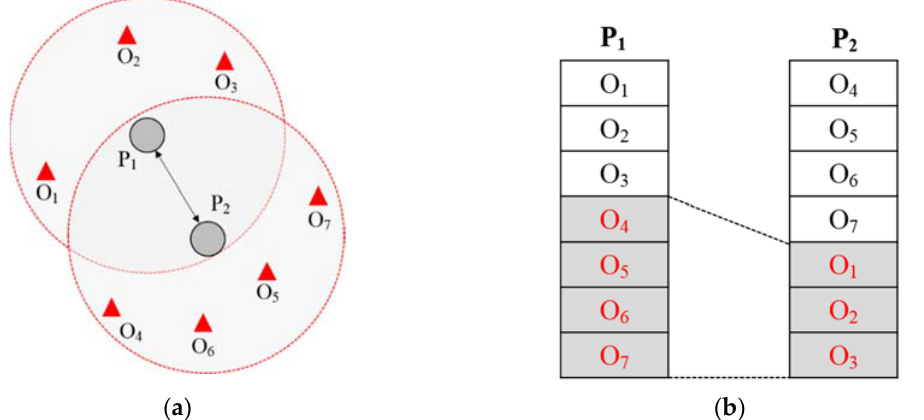
Figure 4. Data dissemination between P 1 and P 2 : ( a ) Communication between P 1 and P 2 ; ( b ) Data dissemination between P 1 and P 2